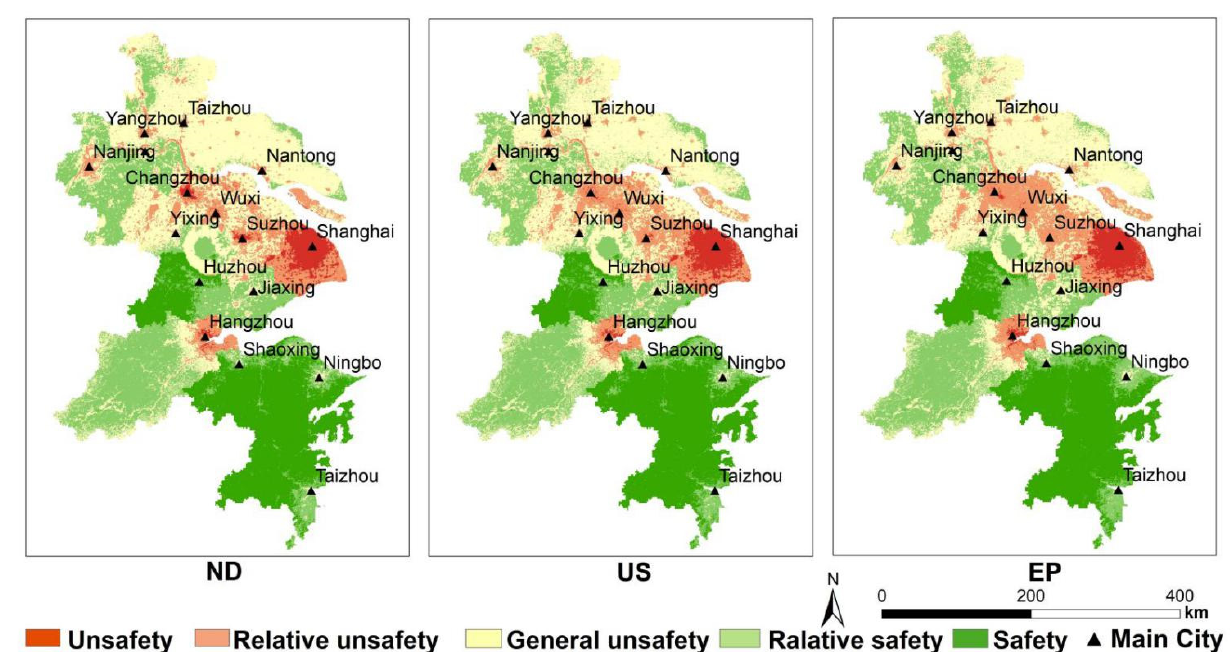
Figure 9. ES pattern of the YRD in 2025 in three scenarios. Table 6. Proportion of ES levels of the YRD in 2025. Unsafety and Relative Unsafety Safety and Relative Safety City ND US EP ND